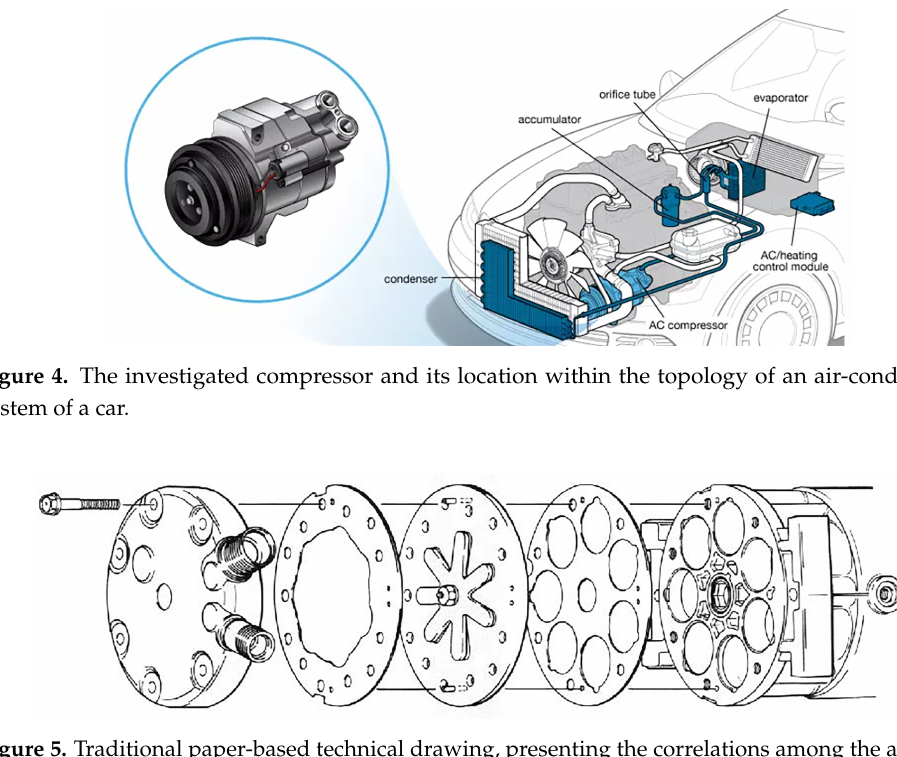
Figure 5. Traditional paper-based technical drawing, presenting the correlations among the assembly parts of the